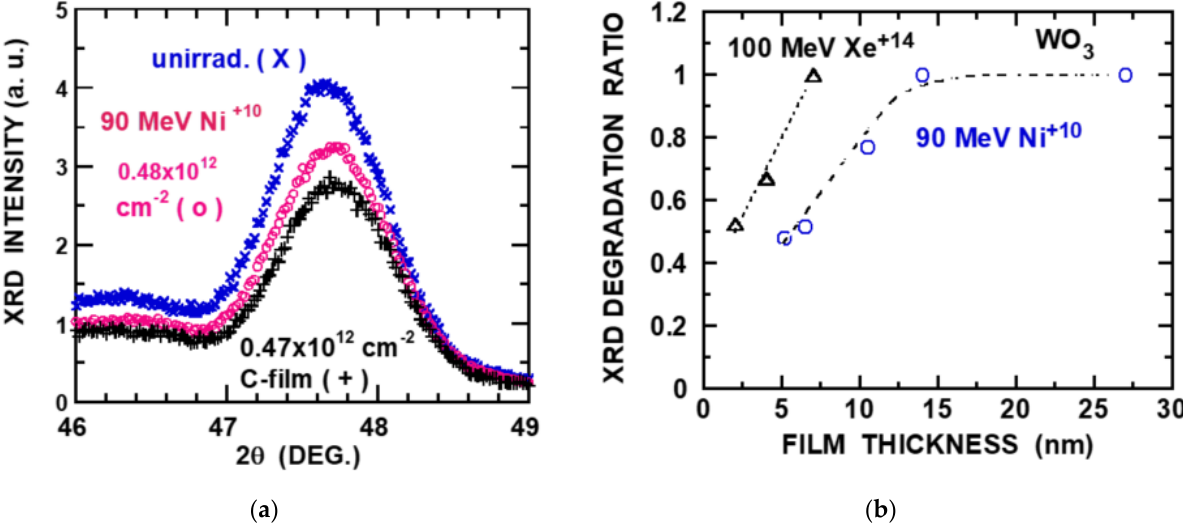
Figure 2. ( a ) XRD patterns of WO 3 films on MgO: unirradiated (x), 90 MeV Ni +10 ions at 0.48 × 10 12 cm − 2 (o) and 90 MeV Ni ions through carbon foils (100 nm), i.e., equilibrium-charge incidence at 0.47 × 10 12 cm − 2 (+). Film thickness is ~6.5 nm. ( b ) Ratio of XRD intensity degradation by irradiation under 90 MeV Ni +10 incidence over that 90 MeV Ni ions with the equilibrium charge (o) and ratio of XRD intensity degradation by irradiation under 100 MeV Xe +14 incidence over that 100 MeV Xe ions with the equilibrium charge ( ∆ ). Dot and dashed lines are guides for eyes. Experimental XRD data are from